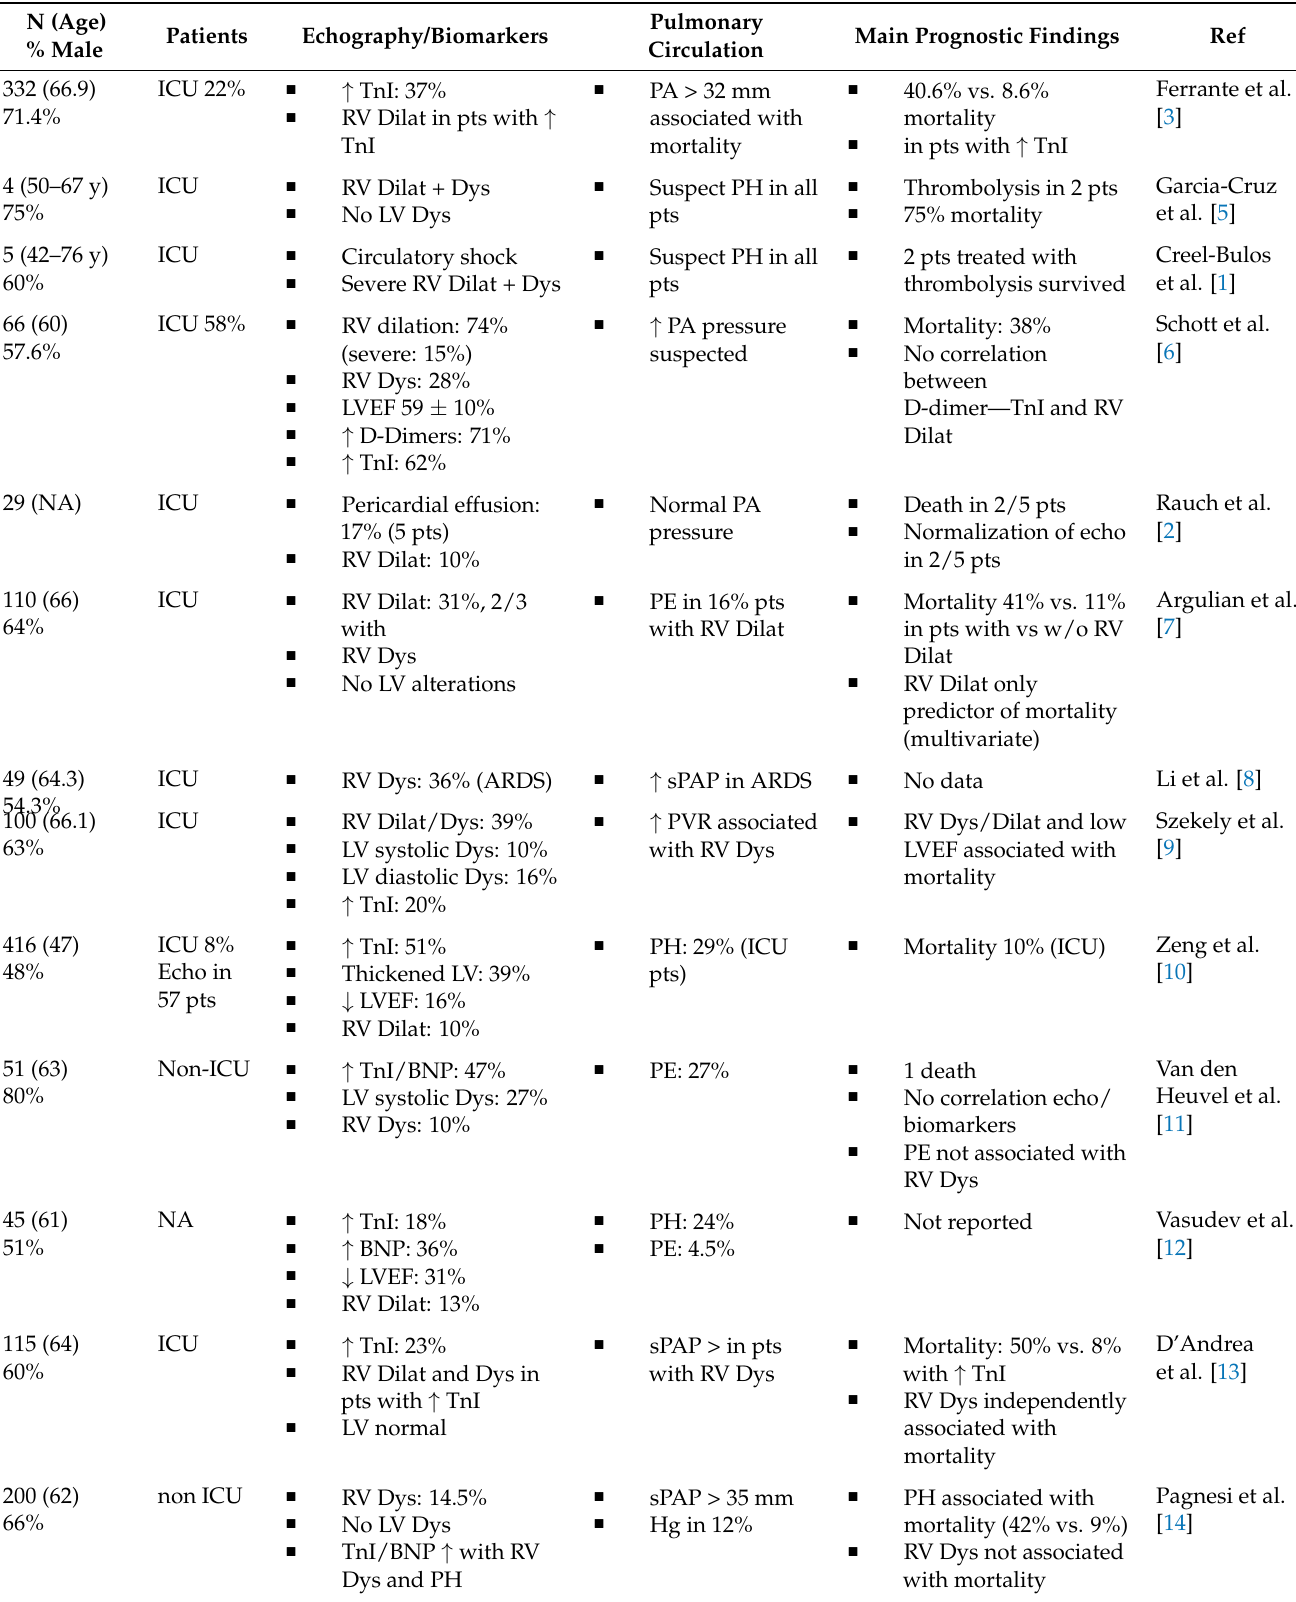
Table 1. Conventional echocardiographic studies in COVID-19